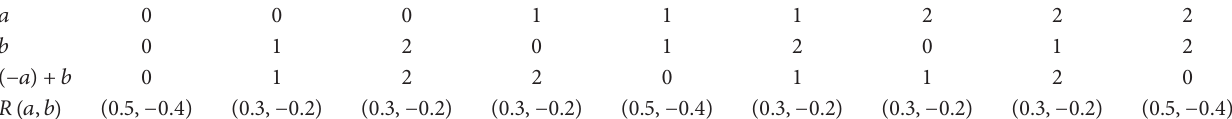
Table 1: 𝑅(𝑎,𝑏) for Cayley bipolar fuzzy graph.